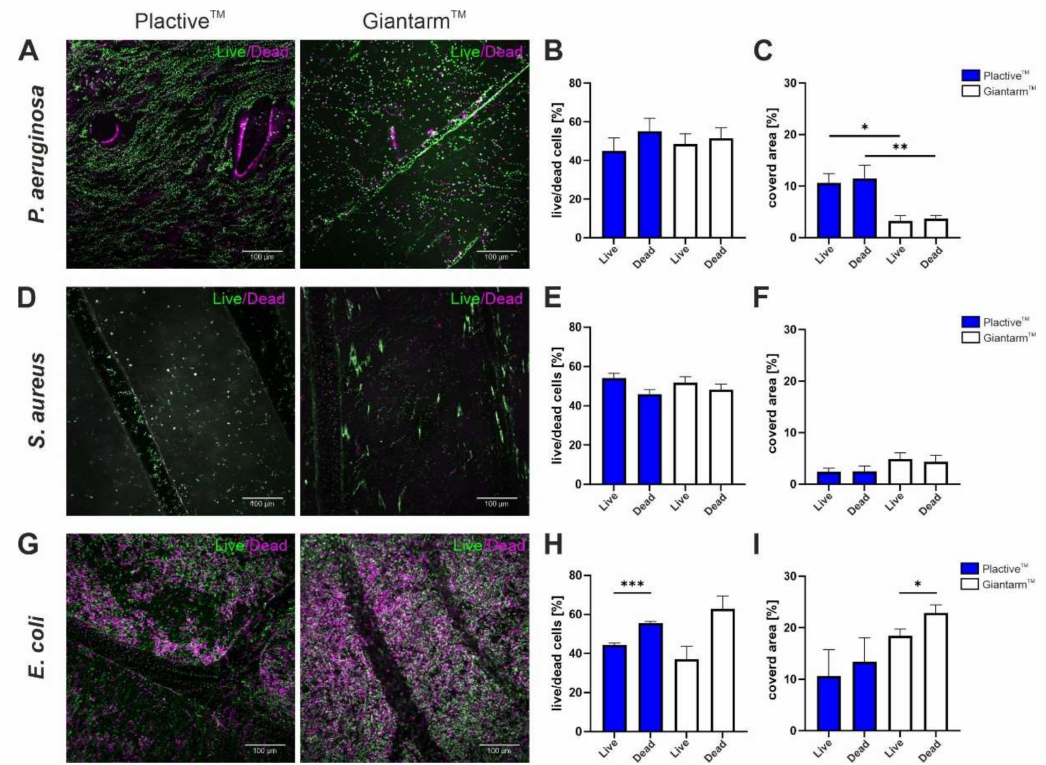
Figure 5. Confocal laser scanning microscope (CLSM) images, percentages of live versus dead cells and percentages of covered area for P. aeruginosa , S. aureus, and E. coli . ( A ) CLSM images of P. aerugi- nosa biofilm formation on Plactive™ PLA (left) and Giantarm™ PLA (right). ( B ) Percentages of live and dead cells of P. aeruginosa on Plactive™ PLA (blue) and Giantarm™ PLA (white). ( C ) Percentages of the bacterial covered area in relation to the uncovered area of P. aeruginosa on Plactive™ PLA (blue) and Giantarm™ PLA (white). ( D ) CLSM images of S. aureus biofilm formation on Plactive™ PLA (left) and Giantarm PLA (right). ( E ) Percentages of live and dead cells of S. aureus on Plactive™ PLA (blue) and Giantarm™ PLA (white). ( F ) Percentages of the bacterial covered area in relation to the uncovered area of S. aureus on Plactive™ PLA (blue) and Giantarm™ PLA (white). Note the strong antimicrobial effect on S. aureus of Plactive™ and Giantarm™. ( G ) CLSM images of E. coli biofilm formation on Plactive™ PLA (left) and Giantarm™ PLA (right). ( H ) Percentages of live and dead cells of E. coli on Plactive™ PLA (blue) and Giantarm™ PLA (white). ( I ) Percentages of the bacterial covered area in relation to the uncovered area of E. coli on Plactive™ PLA (blue) and Giantarm™ PLA